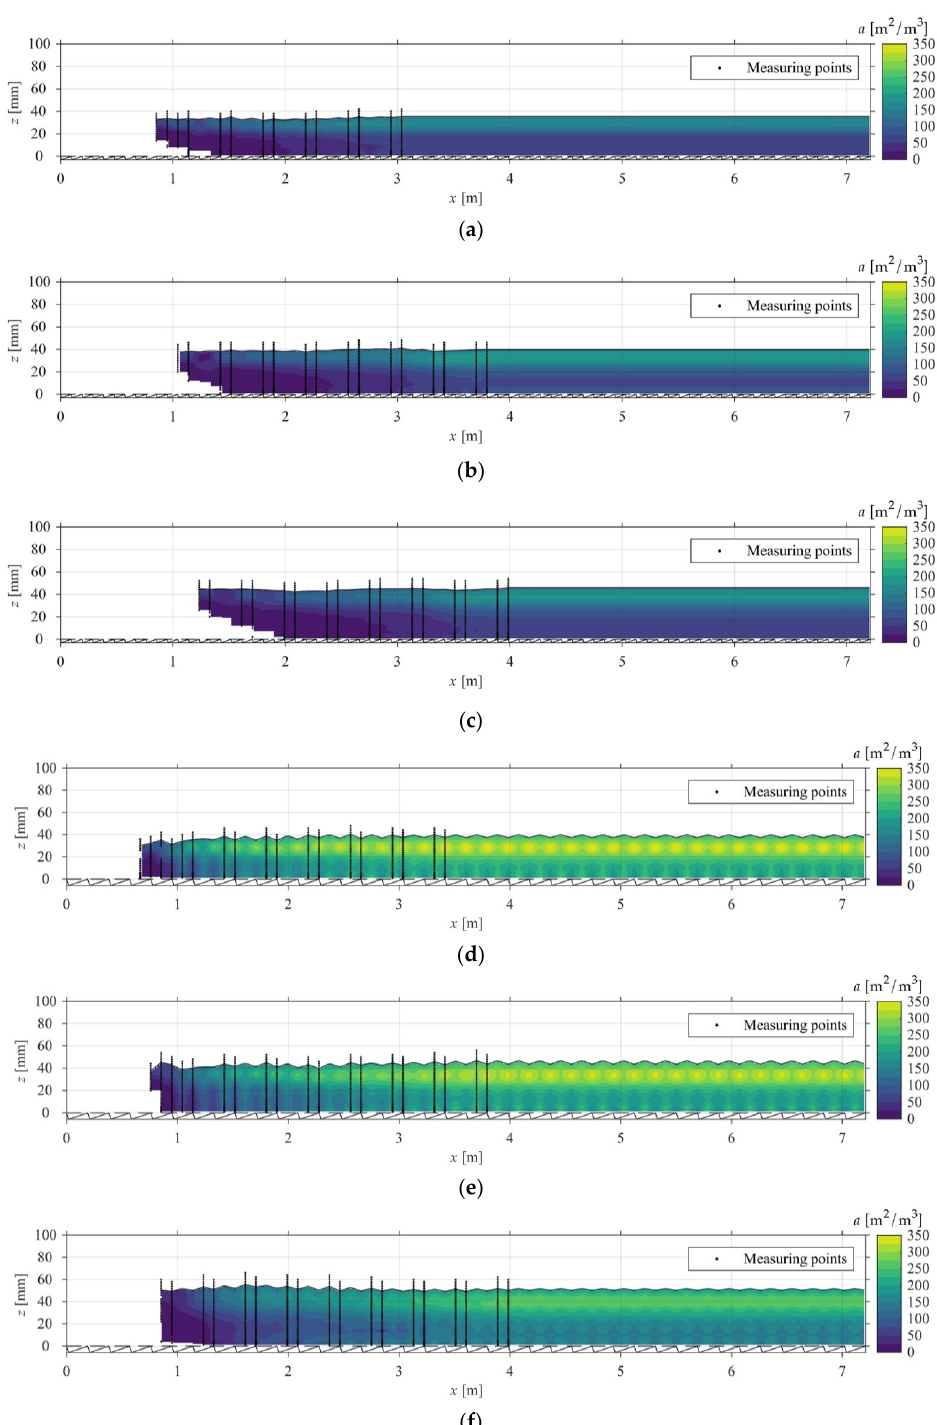
Figure 5. Specific air-water interface a (in m 2 /m 3 ) for all configurations with slope 1:3; downstream of the inception point of self-aeration and from z = 0 (pseudo-bottom) to h 75 ; data in quasi-uniform flow region assumed similar to the last two profiles: ( a ) s = 3 cm, q = 0.07 m 2 /s; ( b ) s = 3 cm, q = 0.09 m 2 /s; ( c ) s = 3 cm, q = 0.11 m 2 /s; ( d ) s = 6 cm, q = 0.07 m 2 /s; ( e ) s = 6 cm, q = 0.09 m 2 /s; ( f ) s = 6 cm, q = 0.11 m 2 /s.